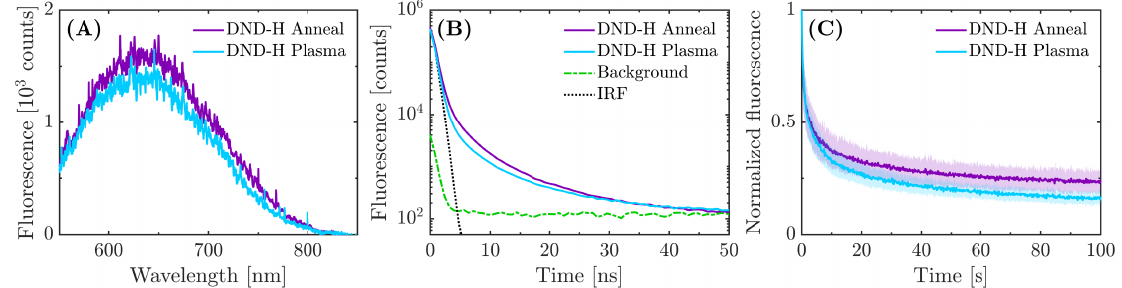
Figure 5. Solid state fluorescence properties of hydrogenated DND particles dispersed on a silicon wafer substrate. ( A ) Fluorescence spectra; ( B ) time-resolved fluorescence decay traces, including background signal and instrument response function (IRF); ( C ) normalized fluorescence intensity as a function of time. Particles were excited with 532 nm pulsed laser light (5 MHz repetition rate, 50 µW average power) and all fluorescence above 540 nm was collected. Each trace represents an average over 10 individual spots. The shaded area in ( C ) represents the standard deviation between individual